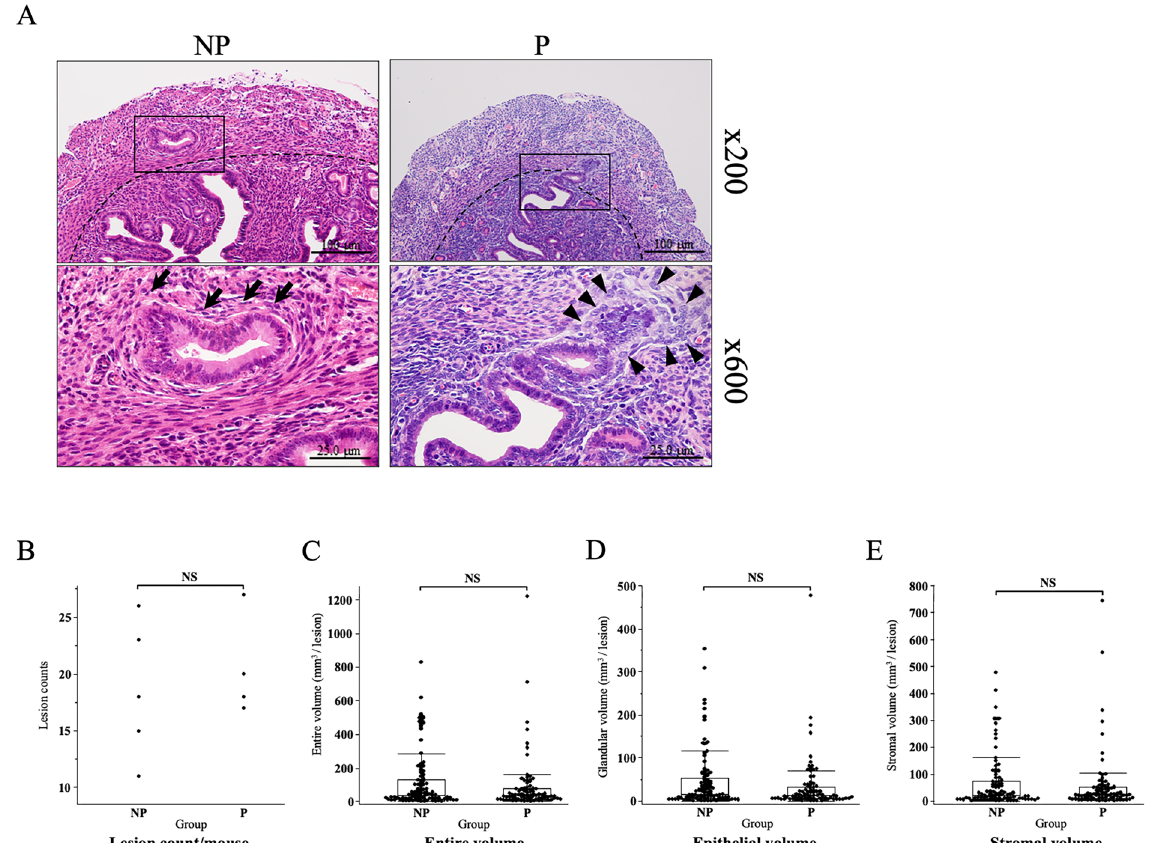
Figure 4. ( A ) A representative microscopic image of the adenomyosis horn (non-pregnant: NP; left, postpartum: P; right) (upper figures; ×200) (lower figures; ×600) hematoxylin and eosin staining of the adenomyosis lesions from non-pregnant (NP) and postpartum (P) mouse. Arrowheads in P mouse indicate a decidualized stromal cells, characterized by the presence of large polygonal cells with a large round or oval vesicular nucleus, while arrows in NP mouse, indicate normal stromal cells, characterized by the presence of spindle shaped cells with a small spindle condensed nucleus. ( B ) A scatters plot for adenomyosis lesion count per mouse. The lesion count in non-pregnant (NP n = 5) and postpartum (P n = 4) mice were compared. ( C–E ) A box and whisker graph for adenomyosis lesion volume. The cross-sectional area of the lesion was measured by tracing the innermost line of the smooth muscle that was identified by positive staining with αSMA and using it as the outermost line of the lesion. The cross-sectional area of the epithelial part of the lesion was measured by tracing the epithelium, with positive CK8 staining, within the adenomyosis lesion. The cross-sectional area of the stromal part of the lesion was calculated by subtracting the area of the epithelial part from the area of the entire lesion. The volumes of each lesion were calculated as the sum of cross-sectional areas multiplied by the inter-slide spacing. The lesion counts ( B ) and volume of the entire ( C ), epithelial ( D ) and stromal ( E ) areas were comparable between NP and P. Box: 25–75%, whisker: 10–90%, midline: median, NS: p >